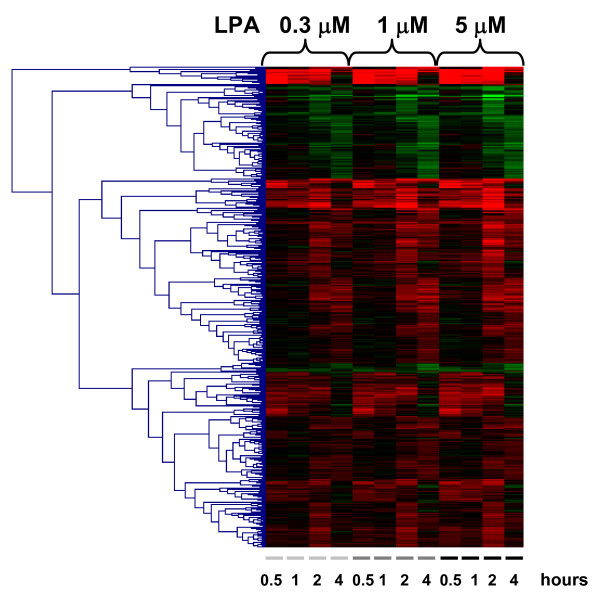
LPA dose dependence. The global transcriptional response of quiescent MEFs to different LPA concentrations (0.3, 1.0 and 5.0 μM) at the indicated time points (0.5–4 hrs). For each time point, transcripts with p < 0.01 in 3 out of 4 measurements were selected; the resulting 915 genes were subjected to hierarchical clustering analysis.